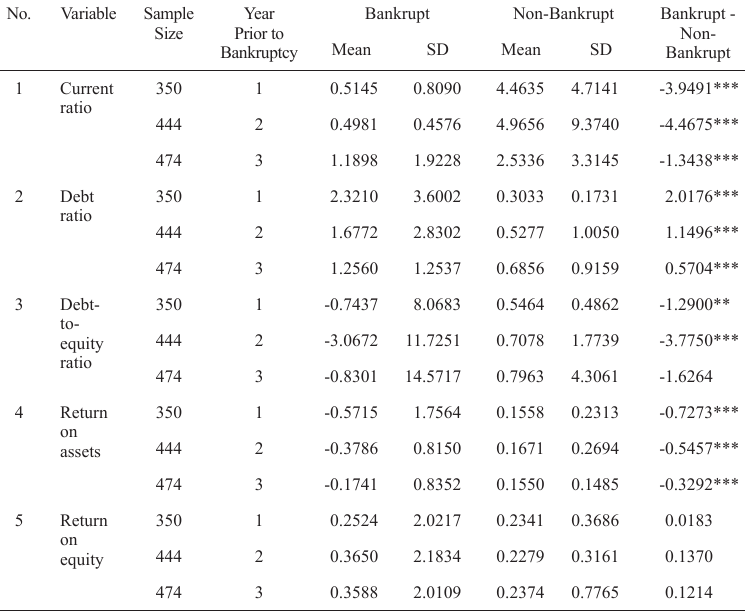
Descriptive Statistics and Mean Difference